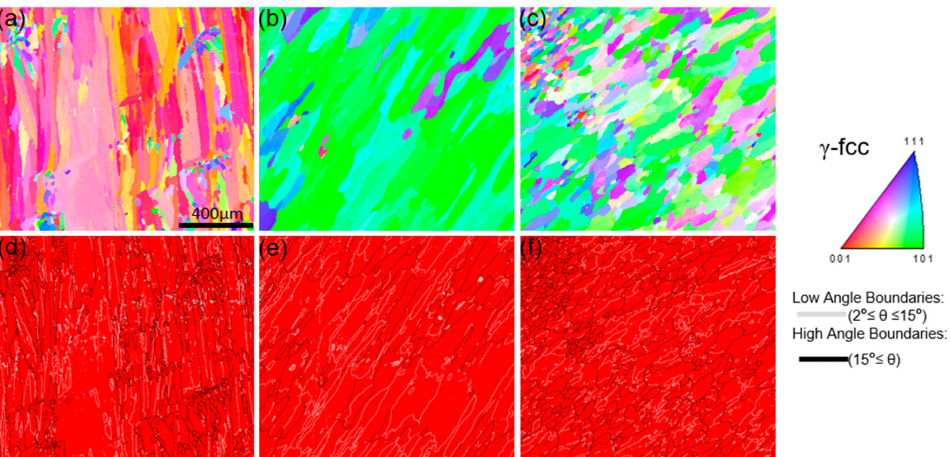
Figure 4. Electron backscatter diffraction (EBSD) inverse polar figure (IPF) maps ( a,b,c ) and image quality (IQ) + phase maps ( d,e,f ) of the EBM-In718 specimens: (a,d) 0 ° sample; (b,e) 55 ° sample and (c,f) 90 ° sample.